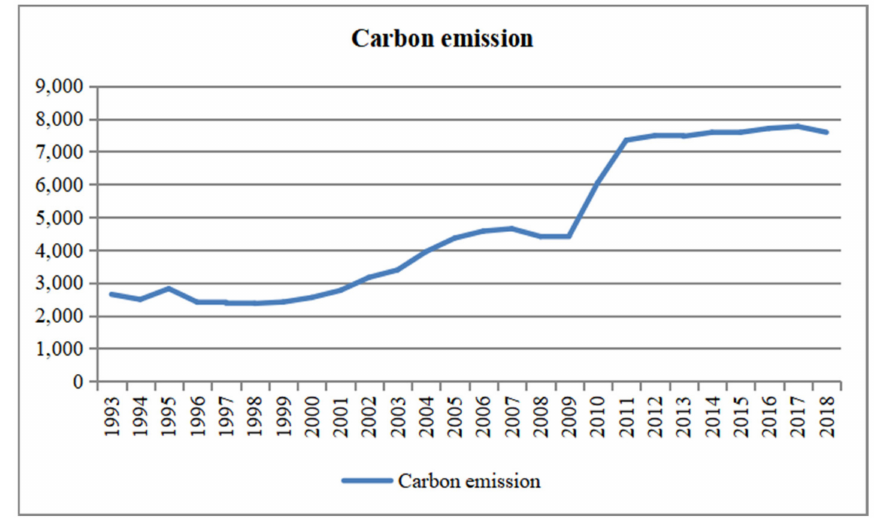
Figure 1. Growth trends in the carbon